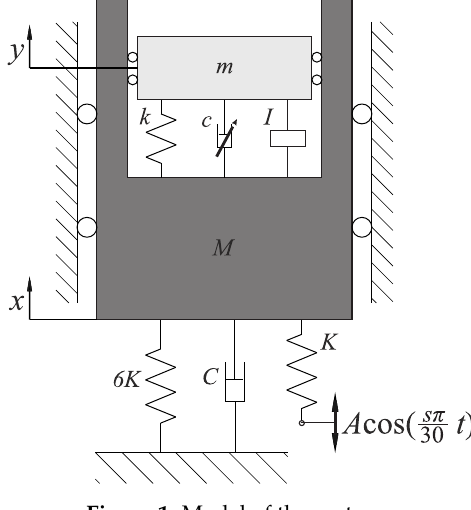
Figure 1. Model of the